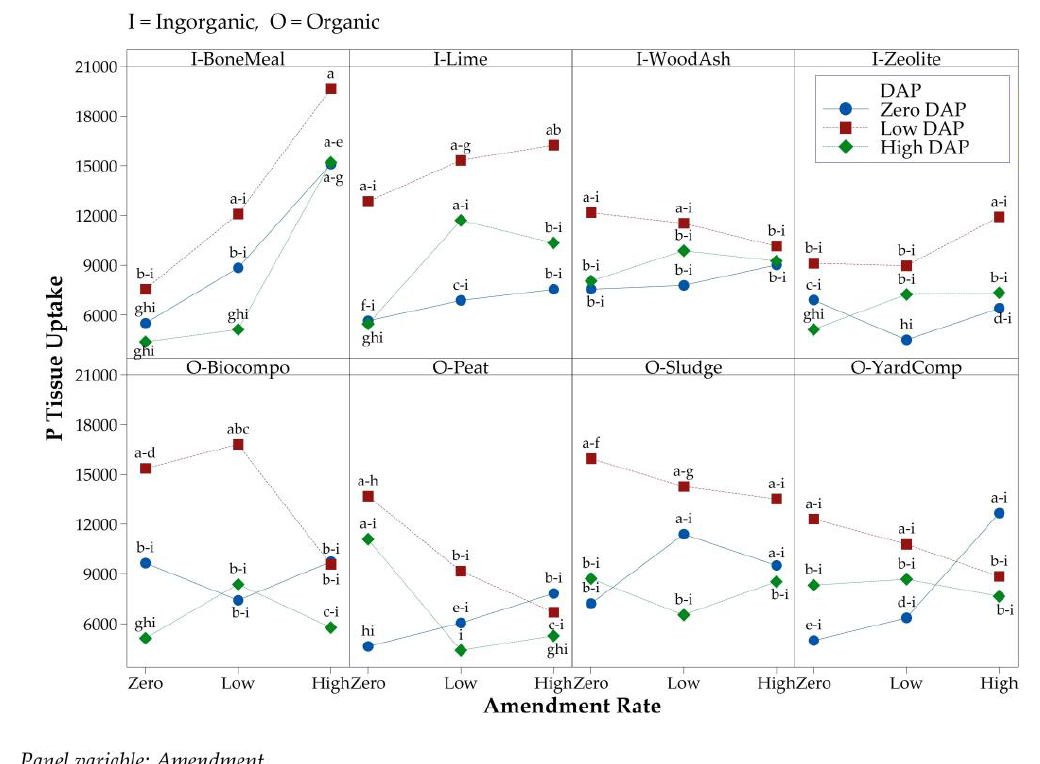
Figure 2. Amendment*Rate*DAP Interaction effect on P tissue uptake plot. The amendments are grouped as Inorganic (I) and organic (O). Means sharing the same letter are not significantly different.